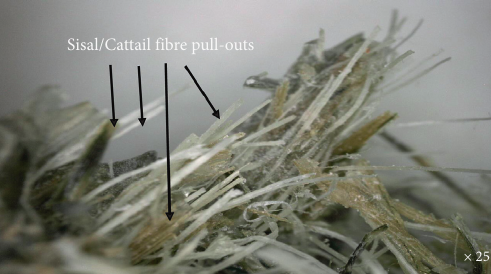
Figure 4: Fracture image of the hybrid composites (20wt% at constant 50/50 sisal/cattail ratio in the blend) after flexural test.